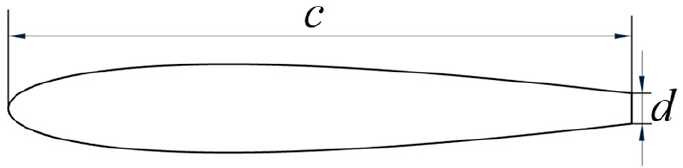
Figure 2. Baseline blunt-trailing-edge airfoil.